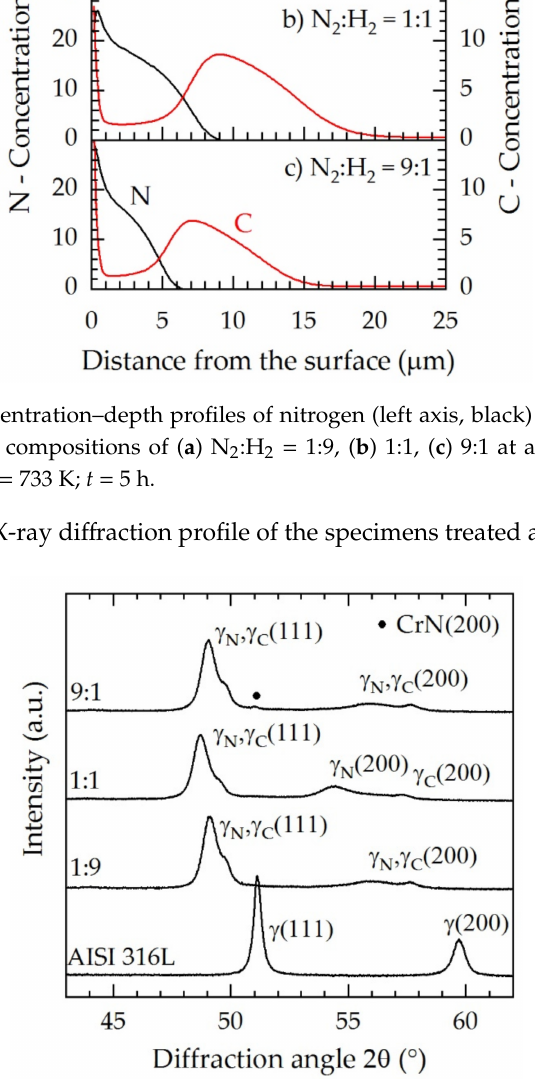
Figure 10. X-ray di ff raction profiles for three feed gas compositions at a fixed screen power of approximately 5 kW, T = 733 K; t = 5